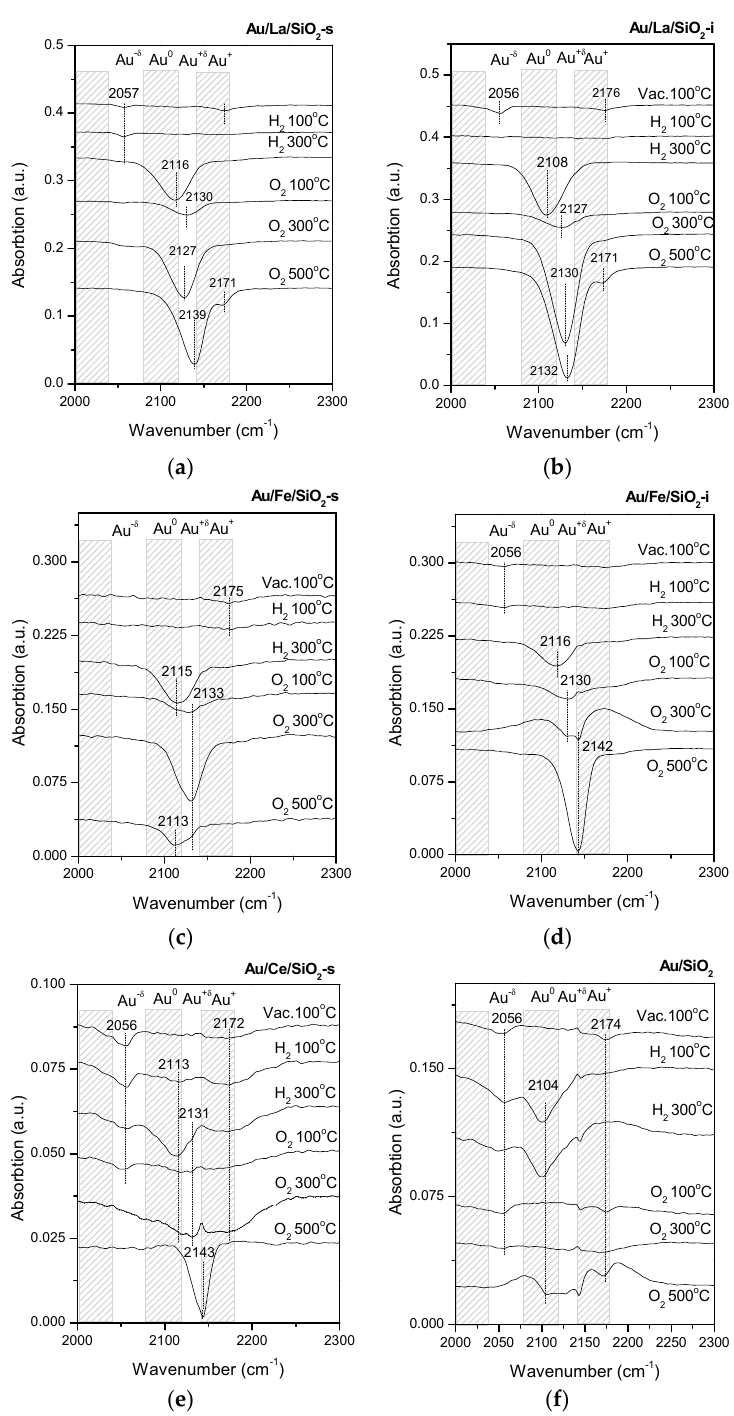
Figure 2. FTIR spectra of CO adsorbed on Au/La/SiO 2 -s ( a ); Au/La/SiO 2 -i ( b ); Au/Fe/SiO 2 -s ( c ); Au/Fe/SiO 2 -i ( d ); Au/Ce/SiO 2 -s ( e ); Au/ SiO 2 ( f ) after different treatments. Subsequent reduction in H 2 at 100° C does not lead to significant changes in the electronic state of gold in the modified catalysts, however, reduction to the Au 0 state (band at 2080–2120 cm − 1 ) occurred in Au/SiO 2 . This may indicate weak metal-support interactions in Au/SiO 2 when compared to the modified Au catalysts.